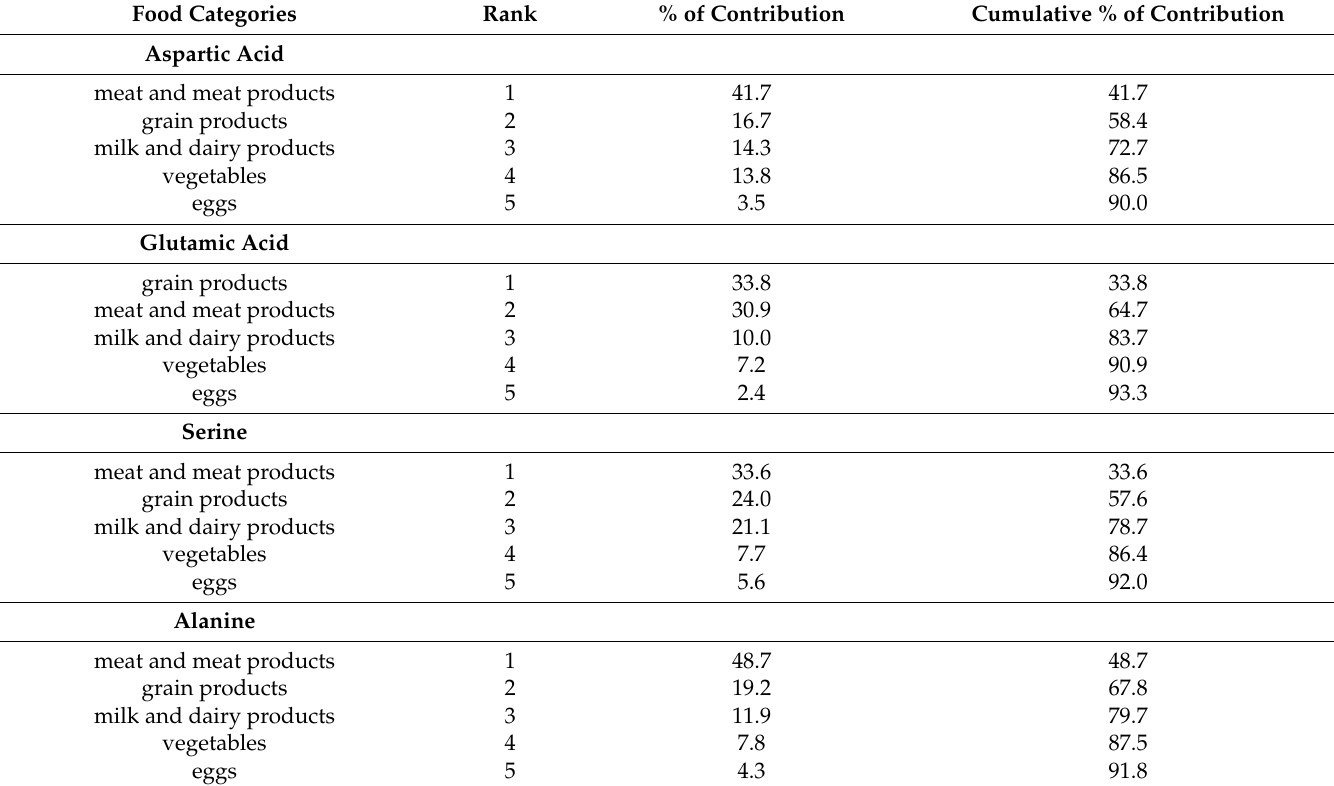
Table 6. Main food category sources of the contribution of aspartic acid, glutamic acid, serine, and alanine to the average Polish